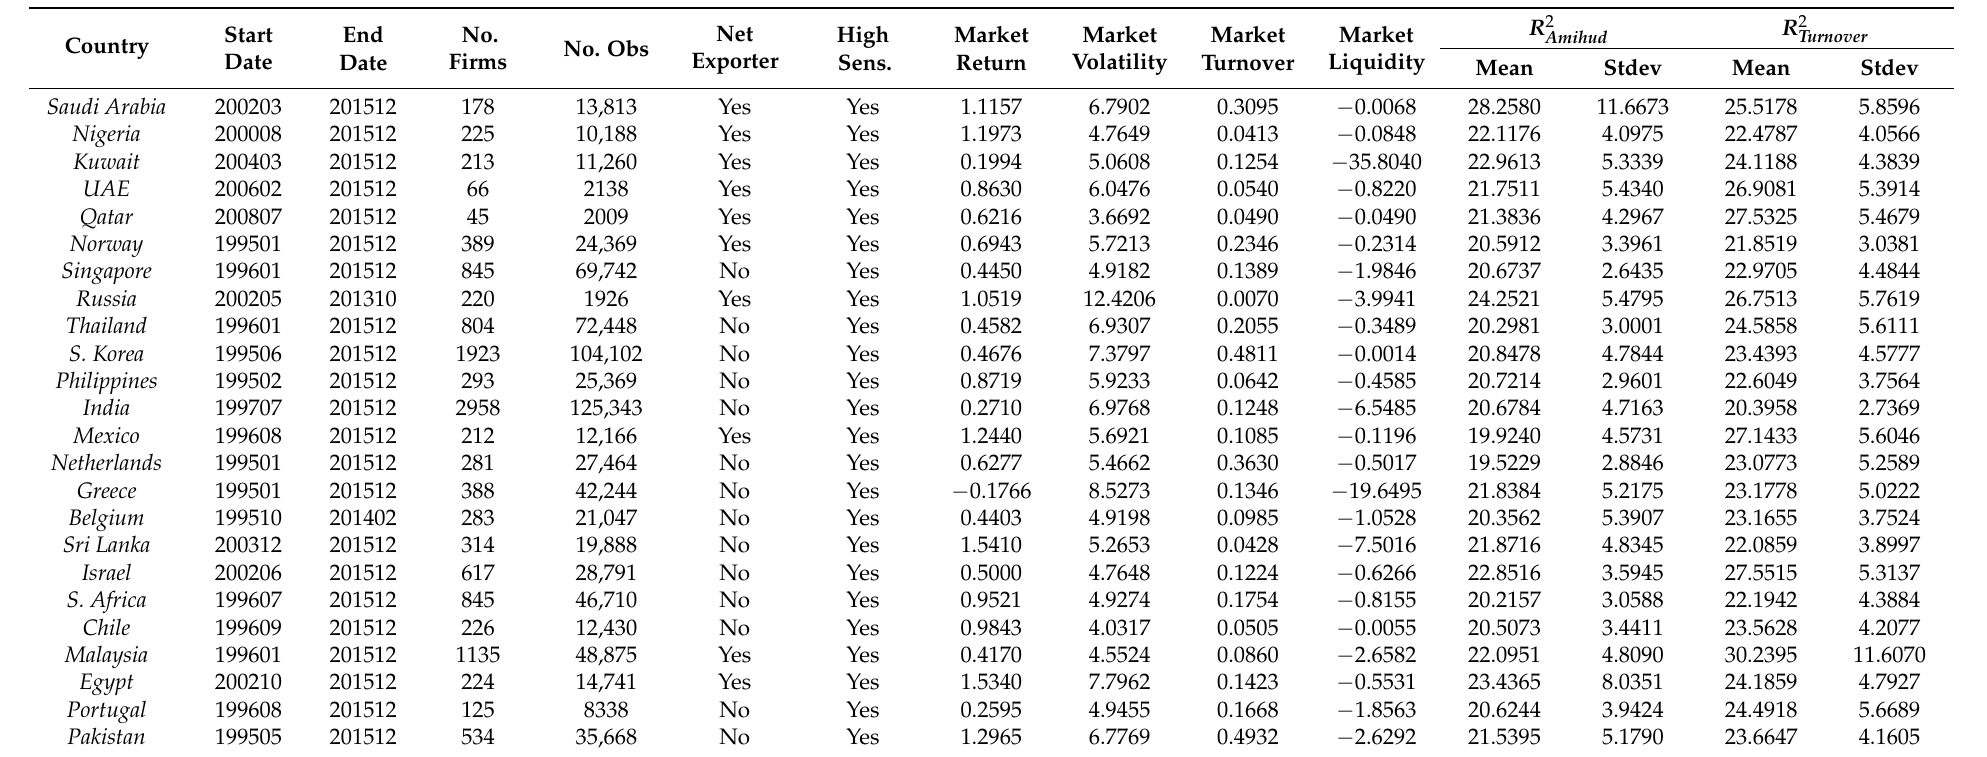
Table 2. Descriptive Statistics of Market Variables and Commonality Measures. This table reports descriptive statistics of a sample from 50 countries spanning from January 1995 to December 2015. For each country, this table reports the start and the end dates of the sample, the number of firms included, the total number of monthly observations, net exporter and high oil sensitivity indicators, and the means of market condition variables. Net exporter indicates whether the country is a net exporter, based on the average of its oil exports and imports. High oil sensitivity indicates whether the country’s average oil sensitivity measure is above the median. The oil sensitivity measure is defined as the absolute value of the difference in oil exports and imports scaled by GDP in constant 2005 US dollars. Market returns, liquidity, and turnover are, respectively, the value-weighted average of the returns, the monthly Amihud measure (computed as the average over the month of the daily absolute stock returns divided by local currency trading volumes (multiplied by − 100,000)), and the turnover of all individual stocks in each country in a given month. The market volatility is the monthly standard deviation of the value-weighted market returns multiplied by the square root of 22 (the number of business days in a month). The commonality measures R 2 and R 2 are defined in detail in Sections 2.2 and 2.4, respectively. The countries are sorted by the average Turnover Amihud oil sensitivity measure: the first country has the highest average oil sensitivity, and the last country has the